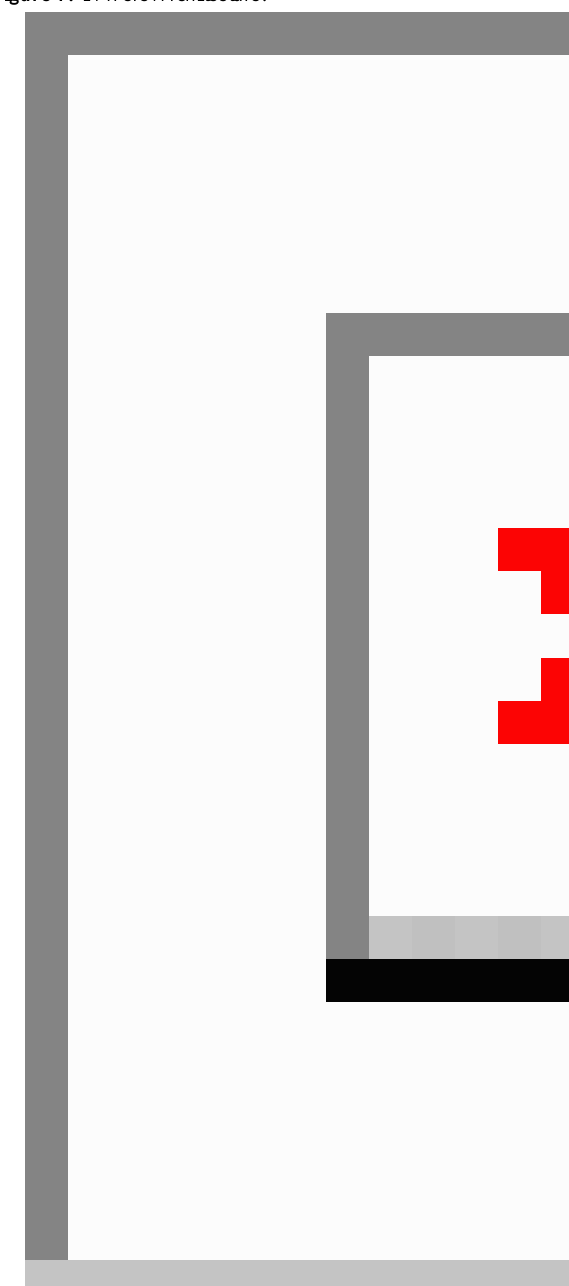
Figure 1. iMHere